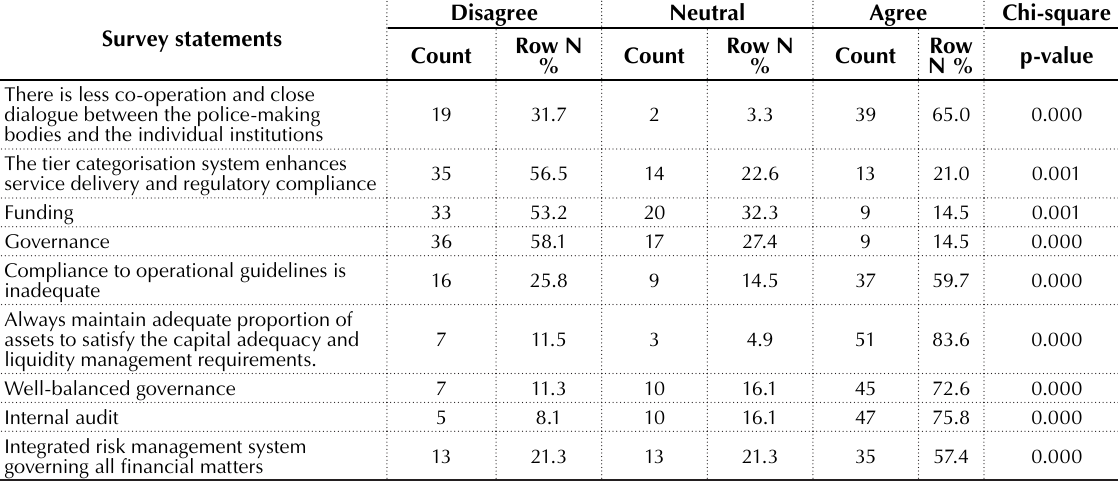
Table 5. Implementation, monitoring and